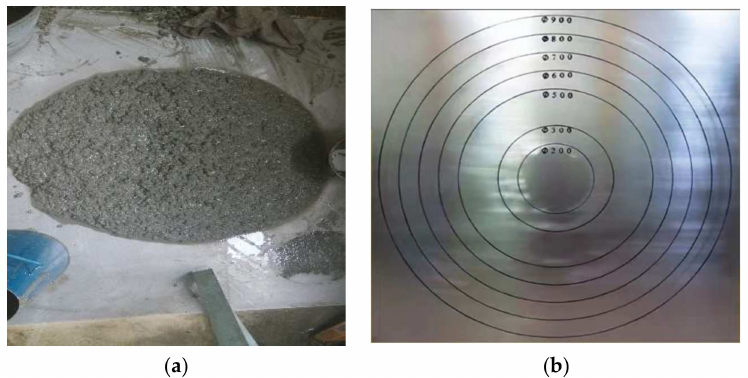
Figure 4. Concrete expansion test. ( a ) Expansion test; ( b ) The steel plate.